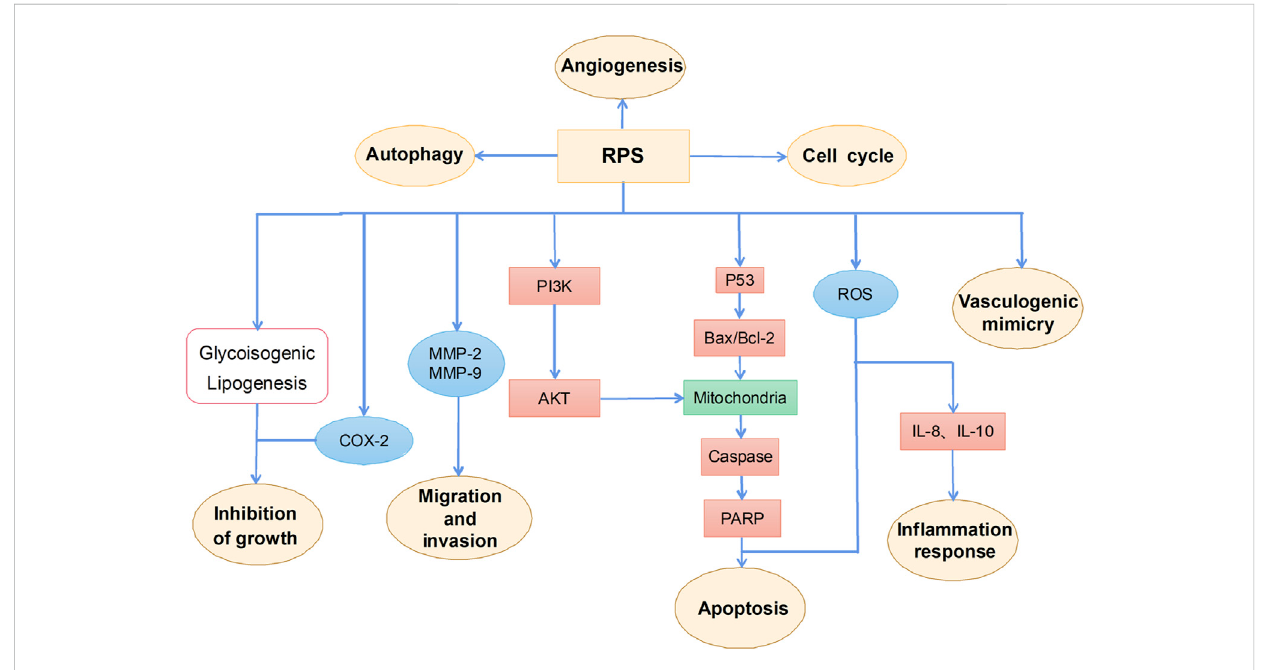
The primary mechanism for the anti-tumor effects of